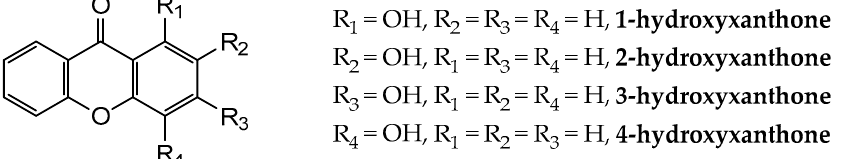
Figure 1. General molecular formulae of the monohydroxyxanthones studied in this work: 1-hydroxyxanthone (1OHXT), 2-hydroxyxanthone (2OHXT), 3-hydroxyxanthone (3OHXT), and 4- hydroxyxanthone (4OHXT).